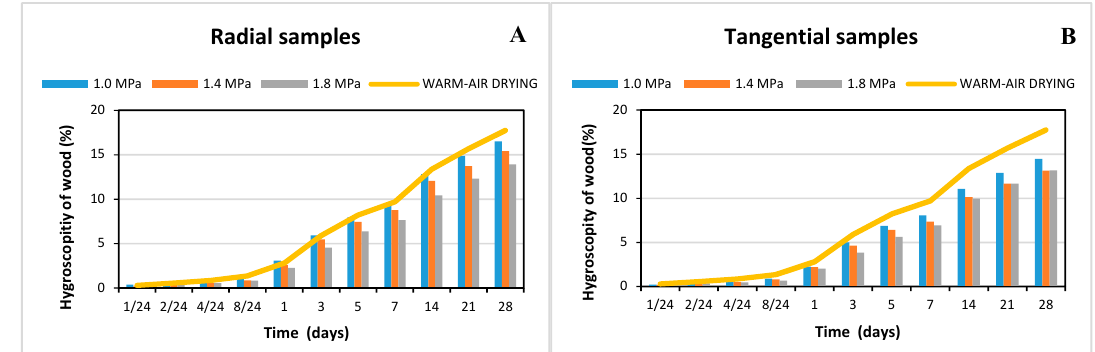
Figure 9. Development of wood hygroscopicity at time in the case of the ( A ) radial and ( B ) tangential samples. Forests 2020 , 11 , x FOR PEER REVIEW